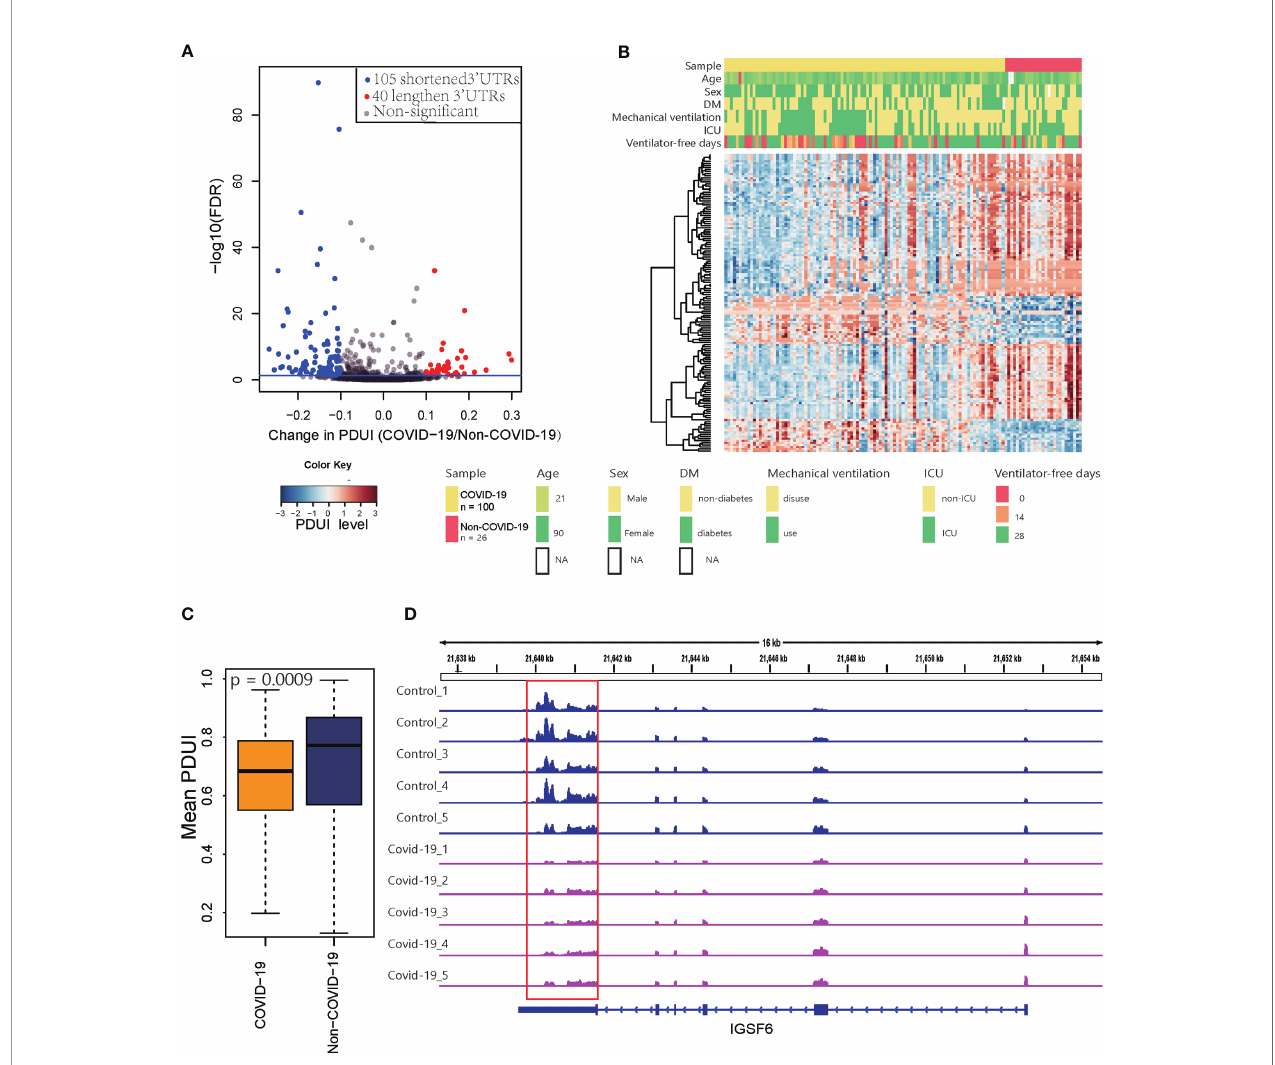
FIGURE 2 | Differential APA analysis for COVID-19. (A) Volcano plot showing the log2FC of PDUI and the statistical signi fi cance of D PDUI between COVID-19 patients and non-COVID-19 patients. Red indicates upregulated APA sites; blue indicates downregulated APA sites. (B) A heat map showing the APA index of all the genes that displayed signi fi cant APA. (C) Average 3 ’ UTR length of non-COVID-19 and COVID-19 patients. (D) Tracks for IGSF6 in 5 COVID-19 samples and 5 control samples randomly selected from 128